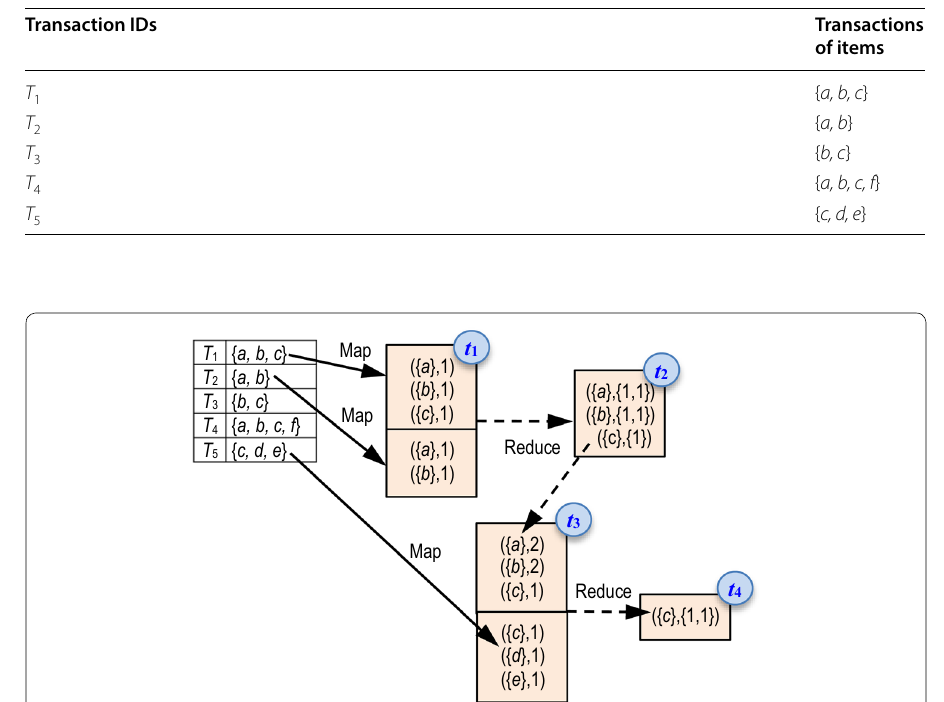
Fig. 5 Partial results of MapReduce executions for 1-itemsets. Illustration of MapReduce execution of 1-itemsets of naïve MapReduce-based